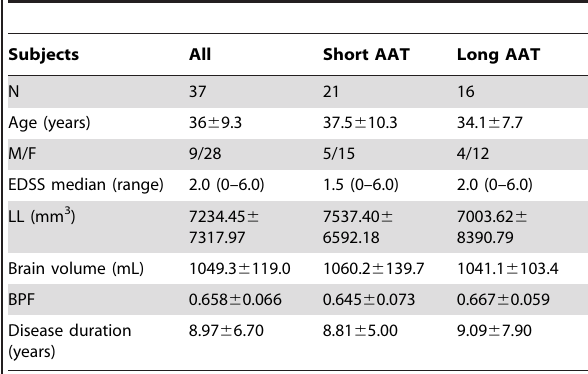
Table 2. Demographic and clinical characteristics of subjects performing MRI